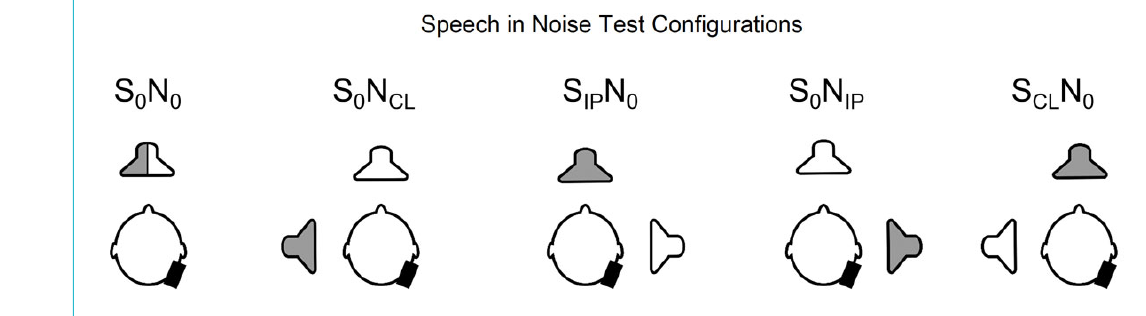
Figure 1: Test settings for speech understanding in noise. S 0 N 0 : speech and noise from the front; S 0 N CL : speech from the front, noise to the contralateral (normal hearing) ear; S IP N 0 : speech to the ipsilateral (implanted) ear, noise from the front; S 0 N IP : speech from the front, noise to the ipsilateral ear; S CL N 0 : speech to the contralateral ear and noise from the front. Gray speaker = noise, white speaker = speech, black rec- tangle = implant